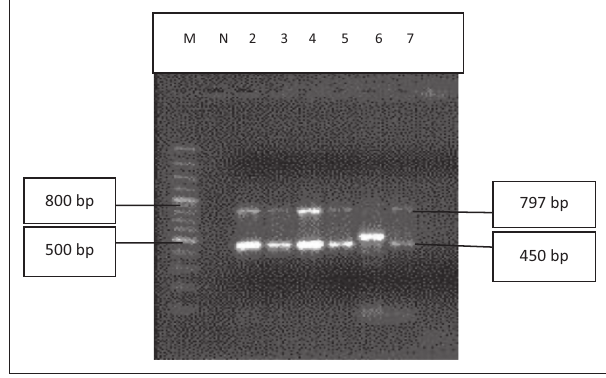
FIGURE 1: Multiplex 1. Lane M indicates the lane containing the marker, GeneRuler 100 bp Plus DNA Ladder (Thermo Scientific, Waltham, Massachusetts, USA), whilst lane N indicates the negative control.